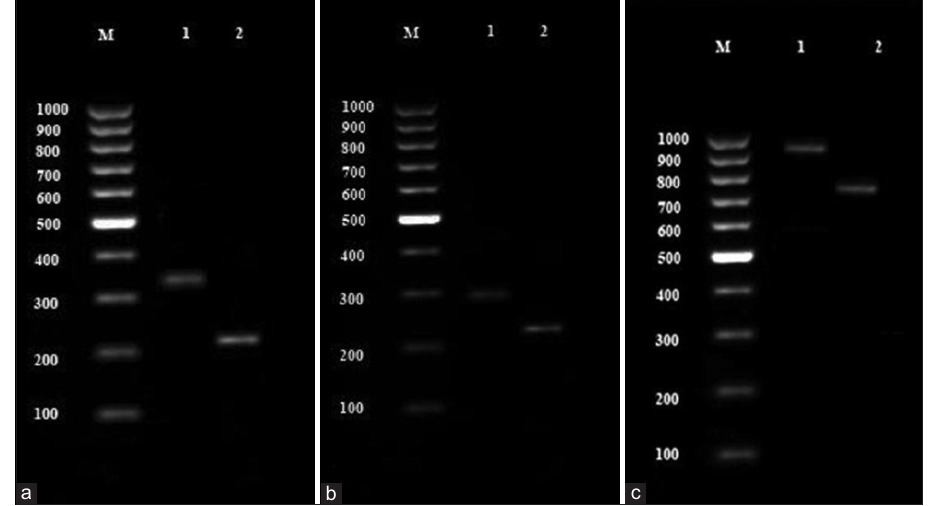
Figure-2: (a) Electrophoresis result of 3´ SAG2 gene nested-polymerase chain reaction (PCR) product: M – 100 bp marker, 1 – 350 bp bond from primary step product, 2 – 221 bp bond from secondary step product. (b) Electrophoresis result of 5´ SAG2 gene nested-PCR product: M – 100 bp marker, 1 – 300 bp bond from primary step product, 2 – 241 bp bond from secondary step product. (c) Electrophoresis result of 3´ GRA6 gene nested-PCR product: M – 100 bp marker, 1 – 950 bp bond from primary step product, 2 – 750 bp bond from secondary step product.